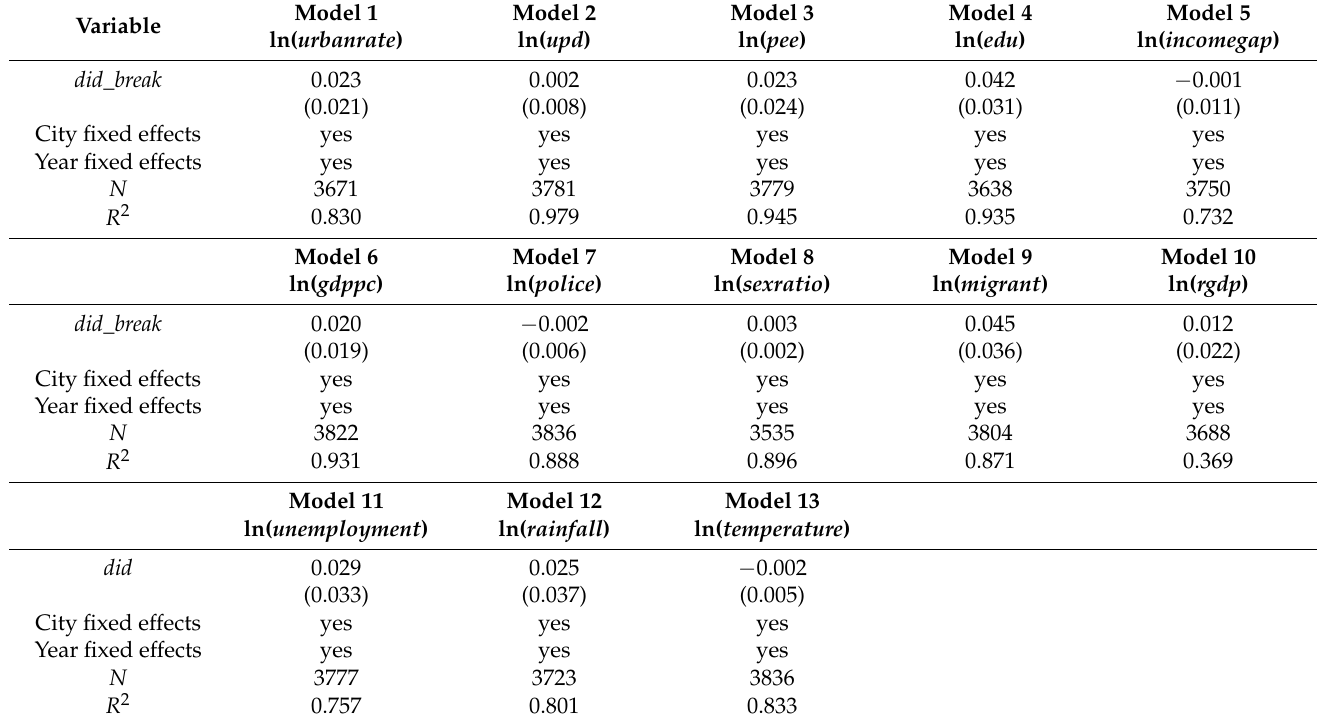
Table 3. Placebo tests.